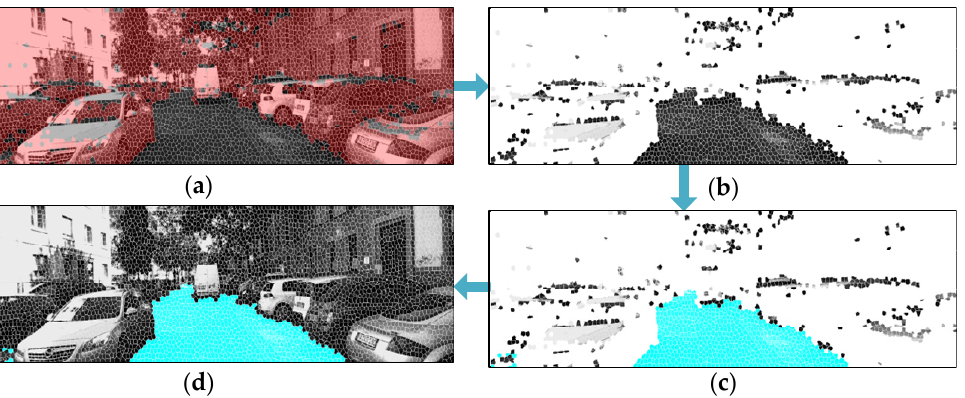
Figure 7. Flow chart of fitting road plane in OD-SPH method: ( a ) Segmentation result of OD-PNV method; ( b ) Extracted free space area (gray area); ( c ) Fitting result of road plane (blue area); ( d ) Display of road plane in the original image.